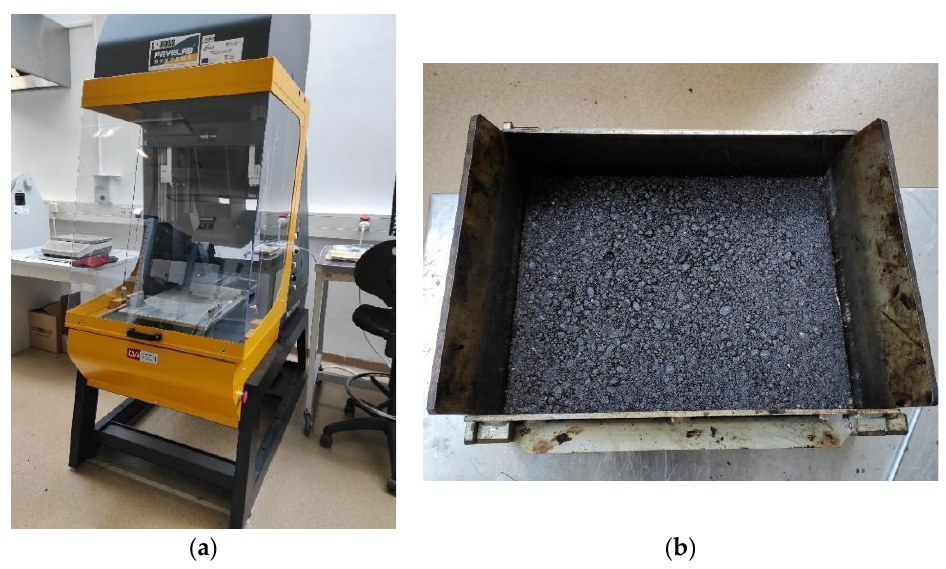
Figure 1. Roller compactor ( a ) and the produced asphalt slab ( b ).